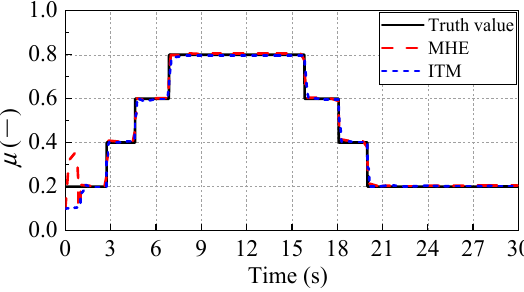
Figure 19. RFC estimated by traditional MHE and ITM.